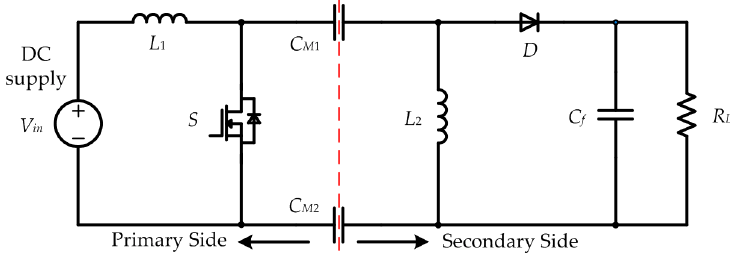
Figure 13. Circuit topology of a CPT system based on sepic converter.